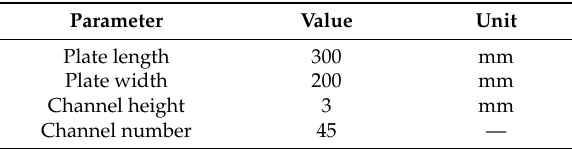
Table 3. The main parameters of the